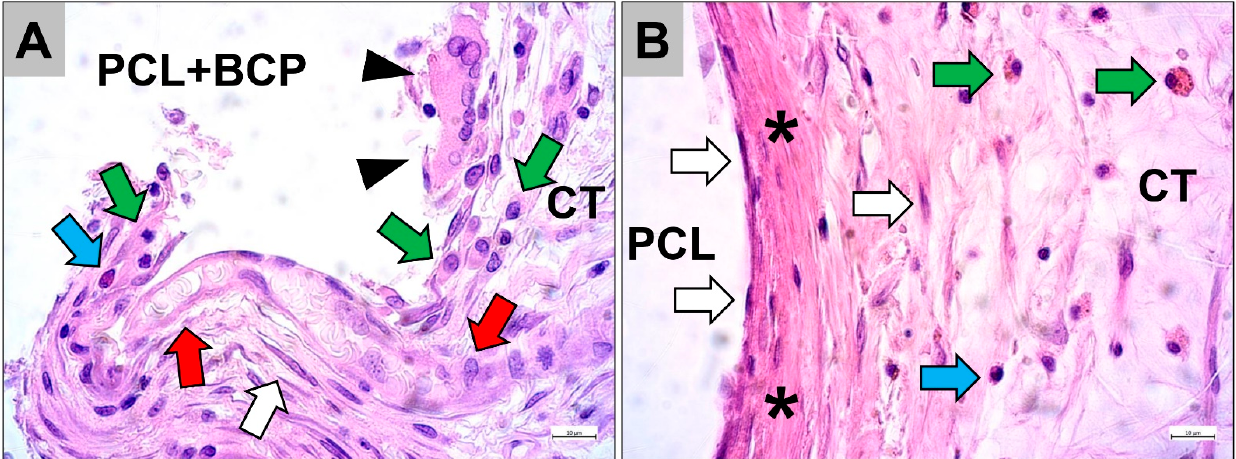
Figure 4. Representative images of the tissue reactions to the PCL scaffolds combined with the BCP granules (PCL+BCP) ( A ) and the pure PCL scaffolds ( B ) within the subcutaneous connective tissue (CT) at day 15 post implantationem. arrowheads = multinucleated giant cell, green arrows = macrophages, white arrows = fibroblasts, blue arrows = granulocytes, red arrows = blood vessel, asterisks = fibrotic capsule (HE-stainings, 400× magnifications, scalebars = 10 µm).